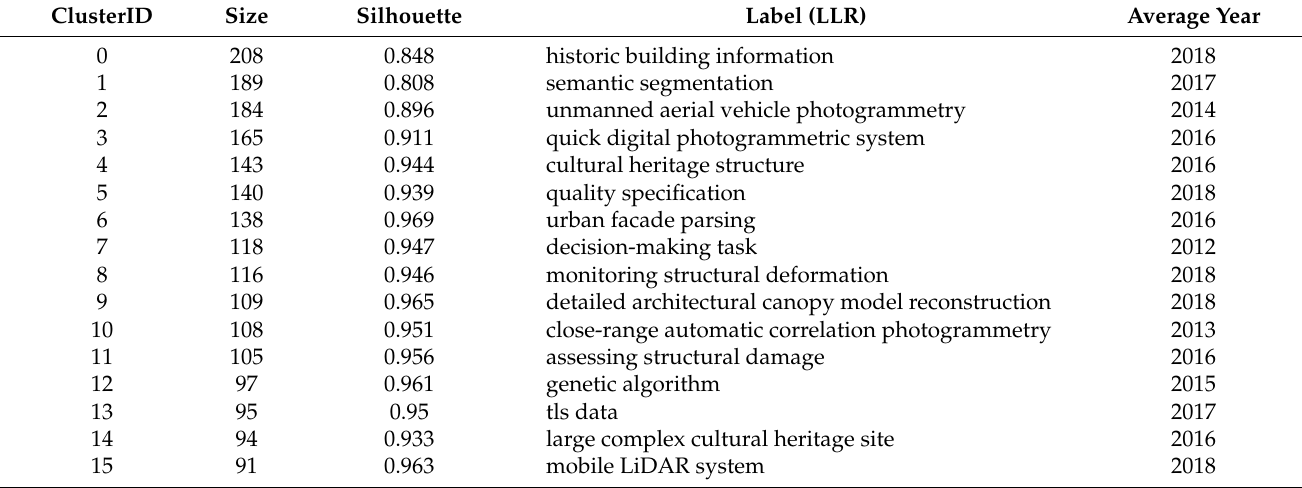
Table 2. A summary of the top 16 clusters in the term co-occurrence